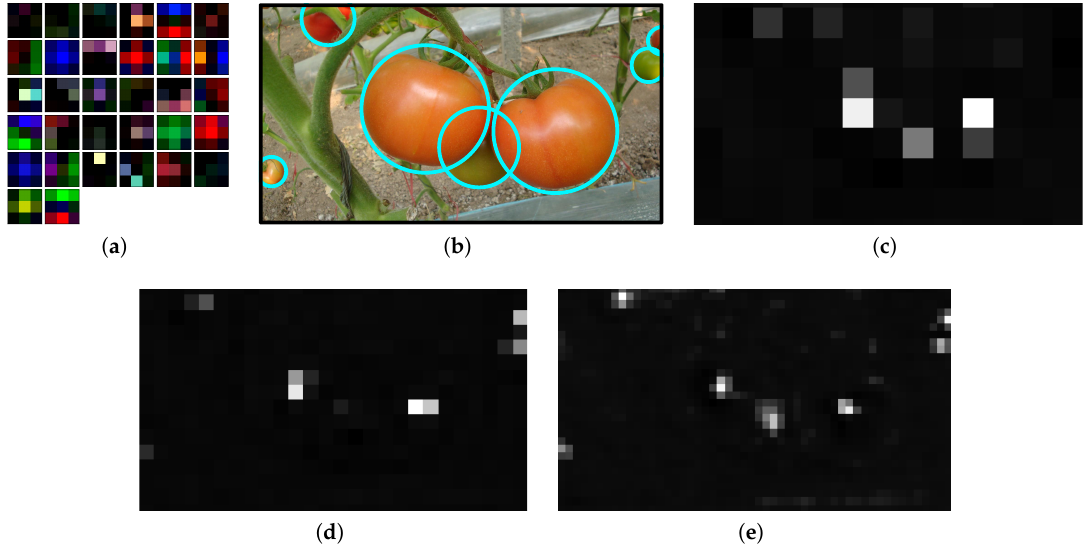
Figure 12. ( a ) the 32 3 × 3 filters of Conv1 of the network, ( b ) the input image (cyan circles are marked manually for a better visualization), and ( c – e ), one of the feature activations from the 80th, 86th, and 92th convolutional layers,